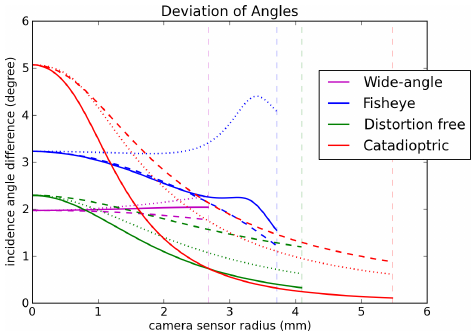
Figure 3: Influence of Radial and Tangential Error Distribu- tion; The graph shows the influence of the two axes identified in the text: radial error distribution (dotted lines) and tangen- tial error distribution (dashed lines). The solid line illustrates the overall effect, by computing the volume for the respective ellipse. σ = 0 . 1 in pixel units. Vertical dashed lines denote maximal pos- sible sensor radius.